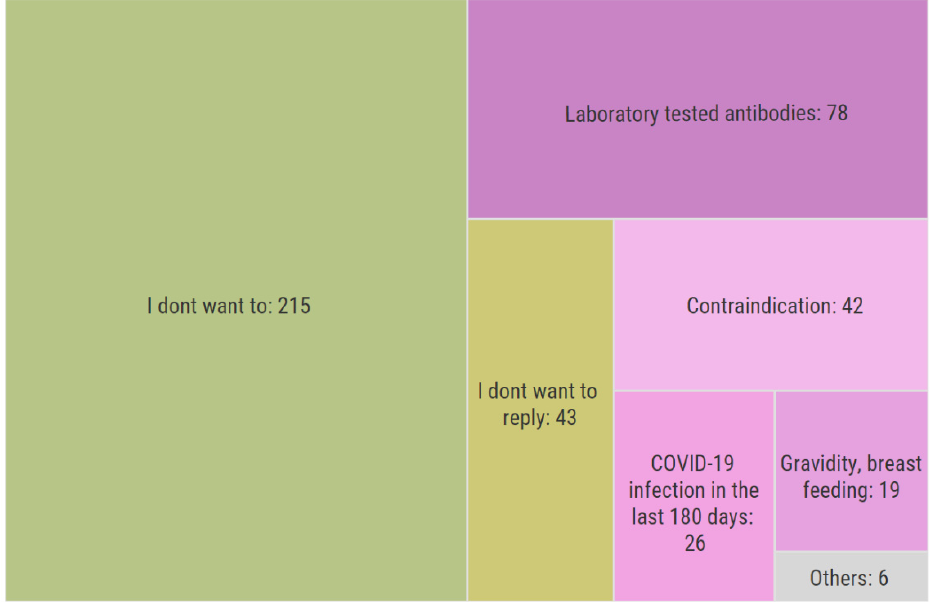
Figure 3. Reasons leading to avoiding COVID-19